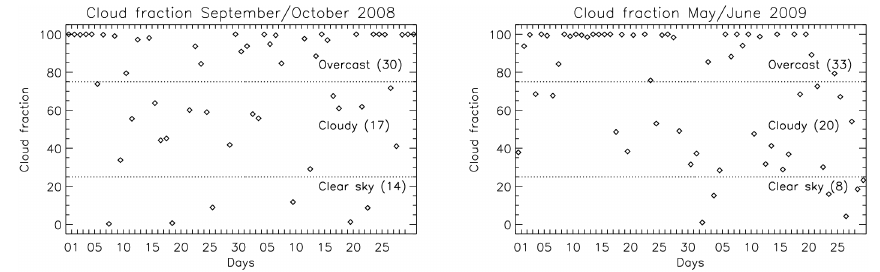
Fig. 5. Classification of the RISC UV periods (left: September–October 2008, right: May–June 2009) at noon in function of the cloud fractions: 0–25% clear sky, 25–75% cloudy, 75–100% overcast situations.